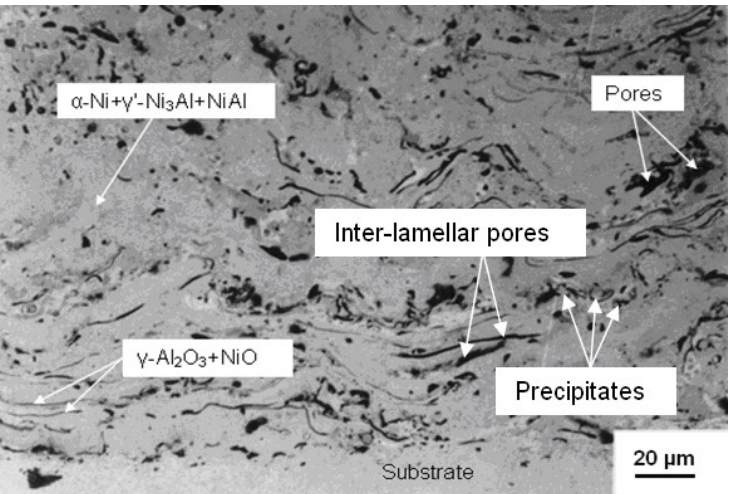
Figure 4 – NI20Al coating microstructure deposited with a (PS) distance of 80